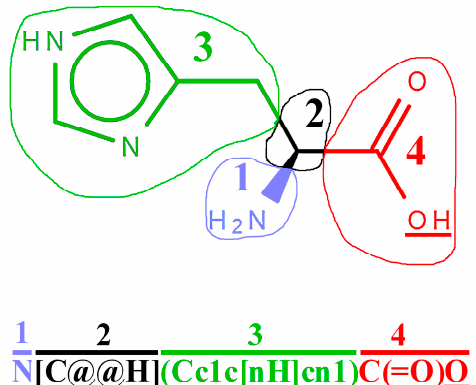
Figure 1. Construction of SMILES string of exemplary amino acid (L-histidine), sufficient for peptide annotation. (1) α -amine group; (2) carbon atom C2; (3) side chain (in this case methylene group and imidazole ring); and, (4) α -carboxyl group. Underlined hydroxyl group in the structure or oxygen atom in SMILES string is replaced by the next amino acid residue during construction of peptide representation. Figure prepared with the help of Ketcher 2.0 molecular editor (EPAM Systems, St. Petersburg, Russia) (Demo version) [86,87].